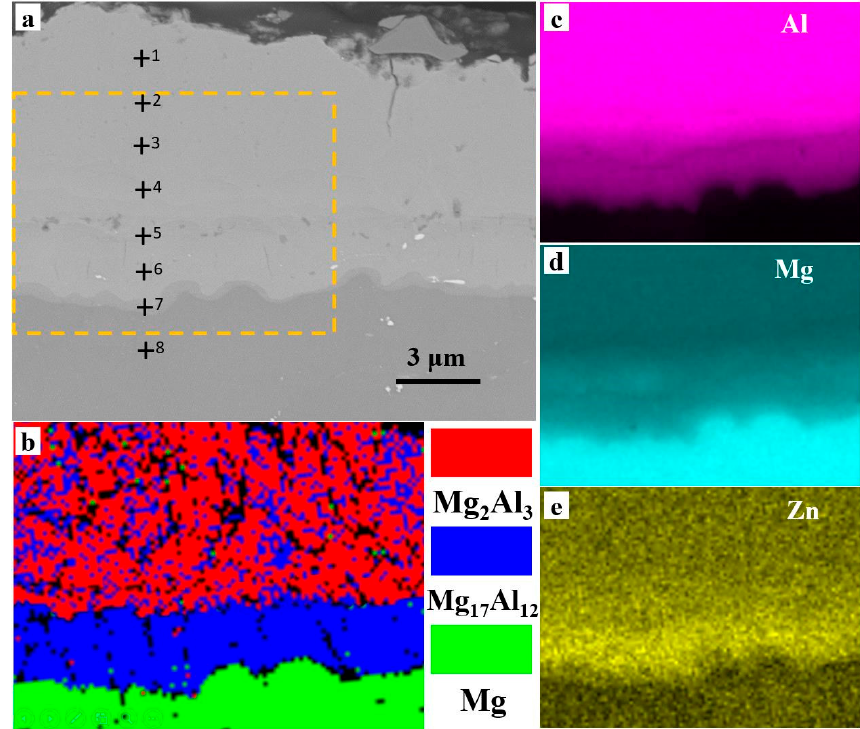
Figure 6. The Electron Backscatter Diffraction (EBSD) and the EDXS analysis of the Al coating after a 350 °C heat treatment for 4 h. ( a ) the cross-sectional morphology, ( b ) EBSD analysis, ( c ), ( d ) and ( e ) the EDXS analysis. Table 2. The EDXS of the Al coating after 350 °C heat treatment for 4 h.